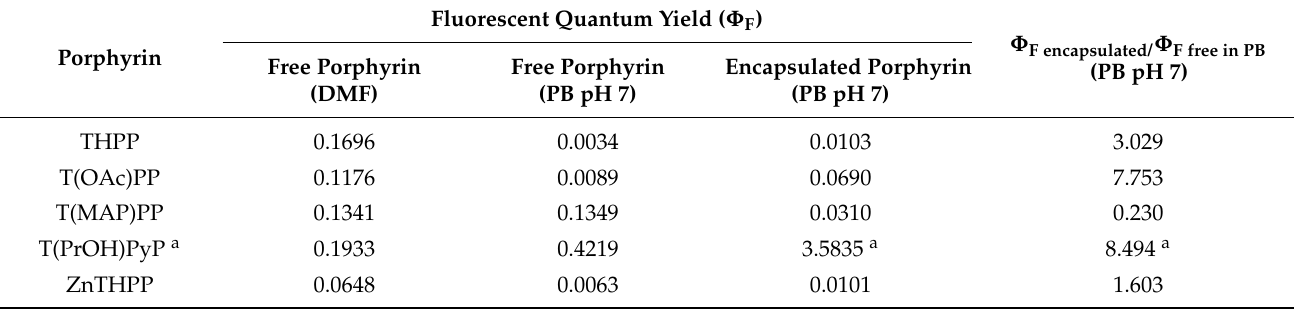
Table 3. Fluorescent quantum yields for porphyrins dissolved in DMF, in PB pH 7 0.5% DMF or encapsulated in acetylated lignin nanoparticles and suspended in PB pH 7. Fluorescent emission was measured at a porphyrin concentration of 0.5 µ M, upon excitation at 425 nm, at 25 ◦ C, and using TPP as a standard ( Φ F = 0.11 in toluene).